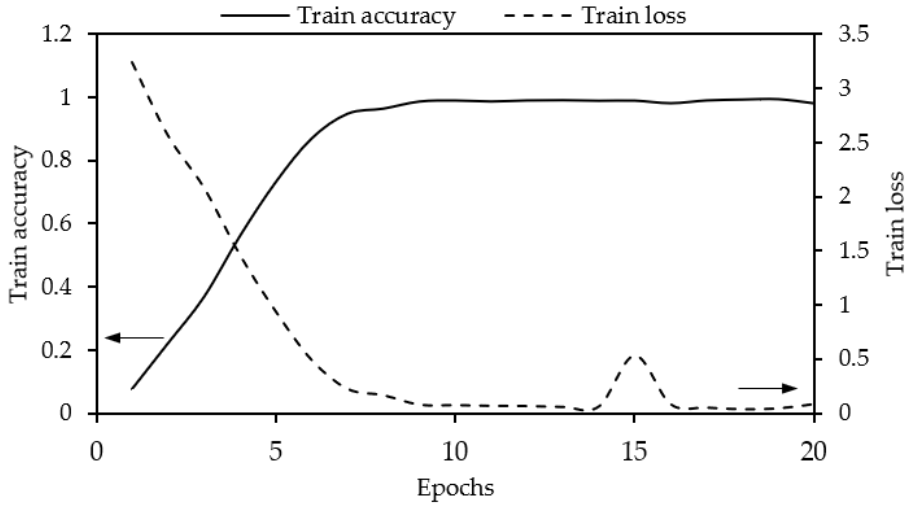
Figure 3. Training results per